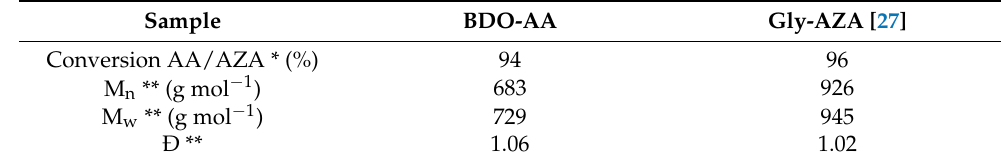
Table 1. Conversions and medium molecular weight values of the enzymatically synthesized polyesters.